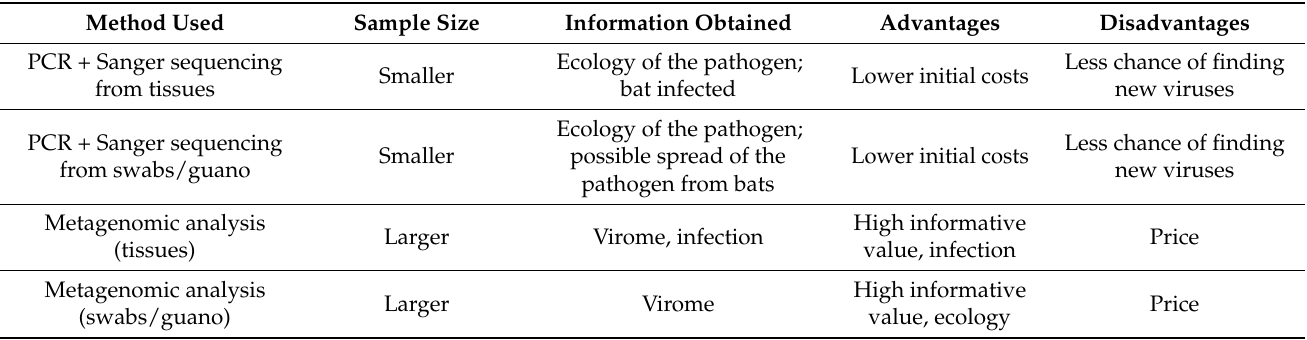
Table 1. Summary of use of the molecular methods in research of bats. The table was composed using the studies cited in this